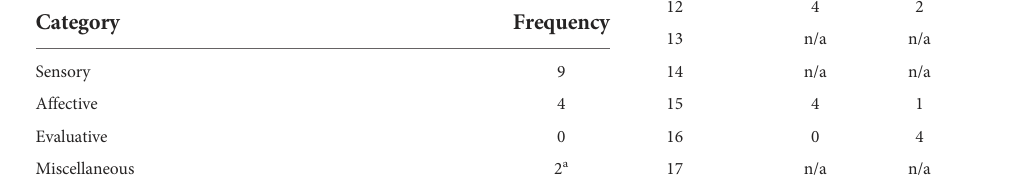
TABLE 1 Frequency of pictures of pain by category.